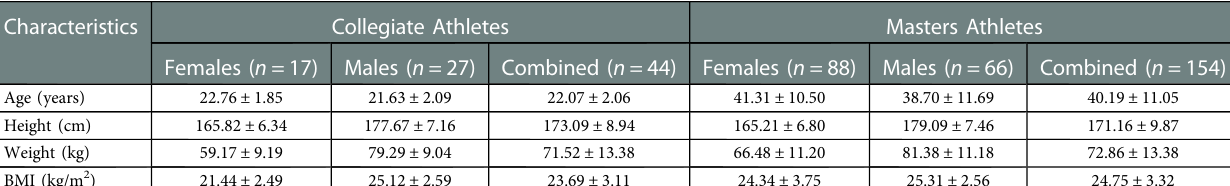
TABLE 1 Descriptive characteristics of collegiate and masters